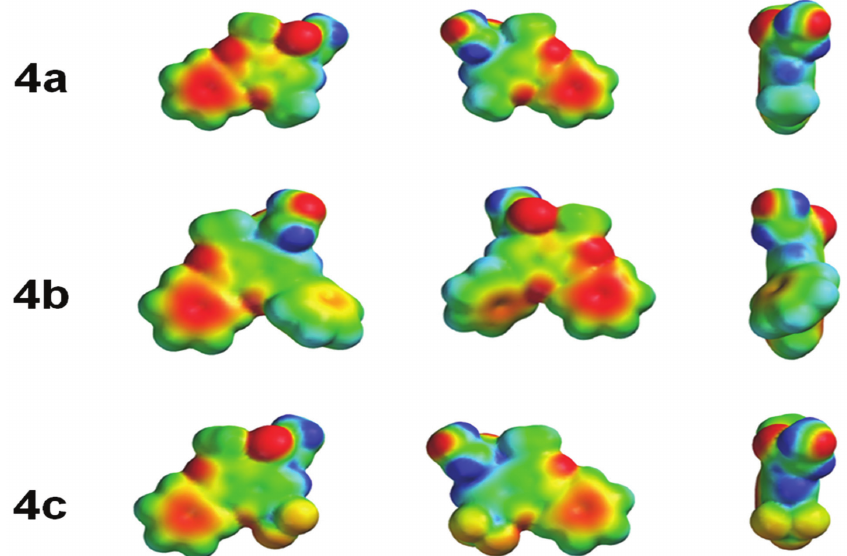
Figure 3 - Electrostatic Potential Maps (EPM) of the most stable conformations of the three carbohydrizide derivatives ( 4a , 4b and 4c ), shown in different positions. The different values of electrostatic potential at the surface are represented by different colors ranging from deepest red (electronegative regions) to deepest blue (electropositive regions).